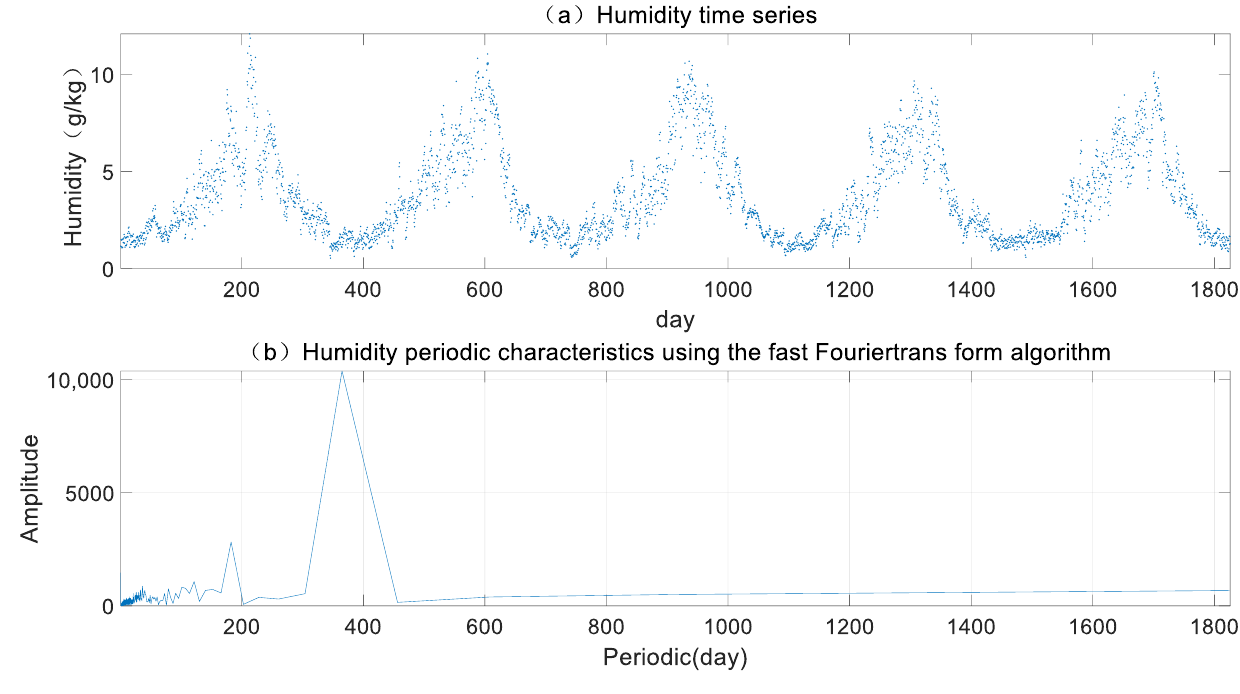
Figure 2. ( a ) humidity time series at a specific atmospheric pressure of 1000 hPa and ( b ) its periodic characteristics.